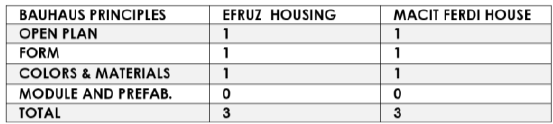
Table 1. Comparison between Bauahus and